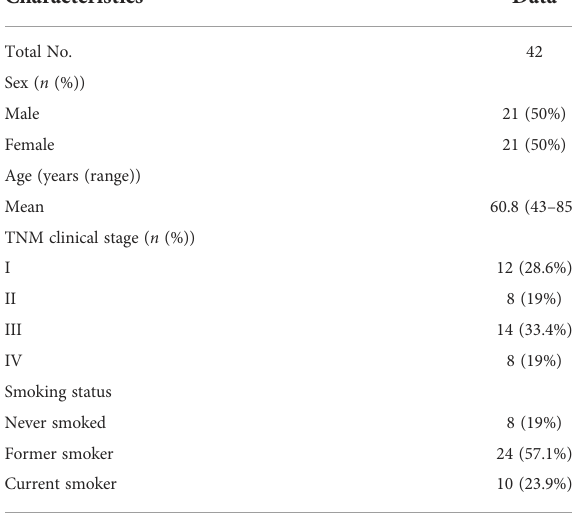
TABLE 1 Clinicopathological